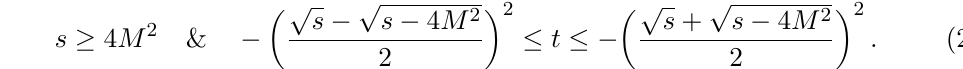
¯ Q . Thin lines indicate a light quark ) 2 , satisfying the − p 2 3